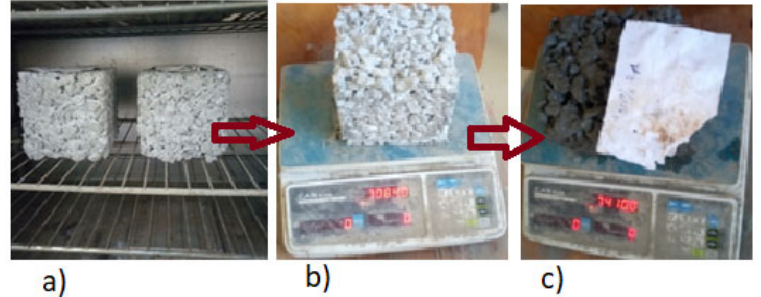
Figure 4. Determination of the porosity of concrete.